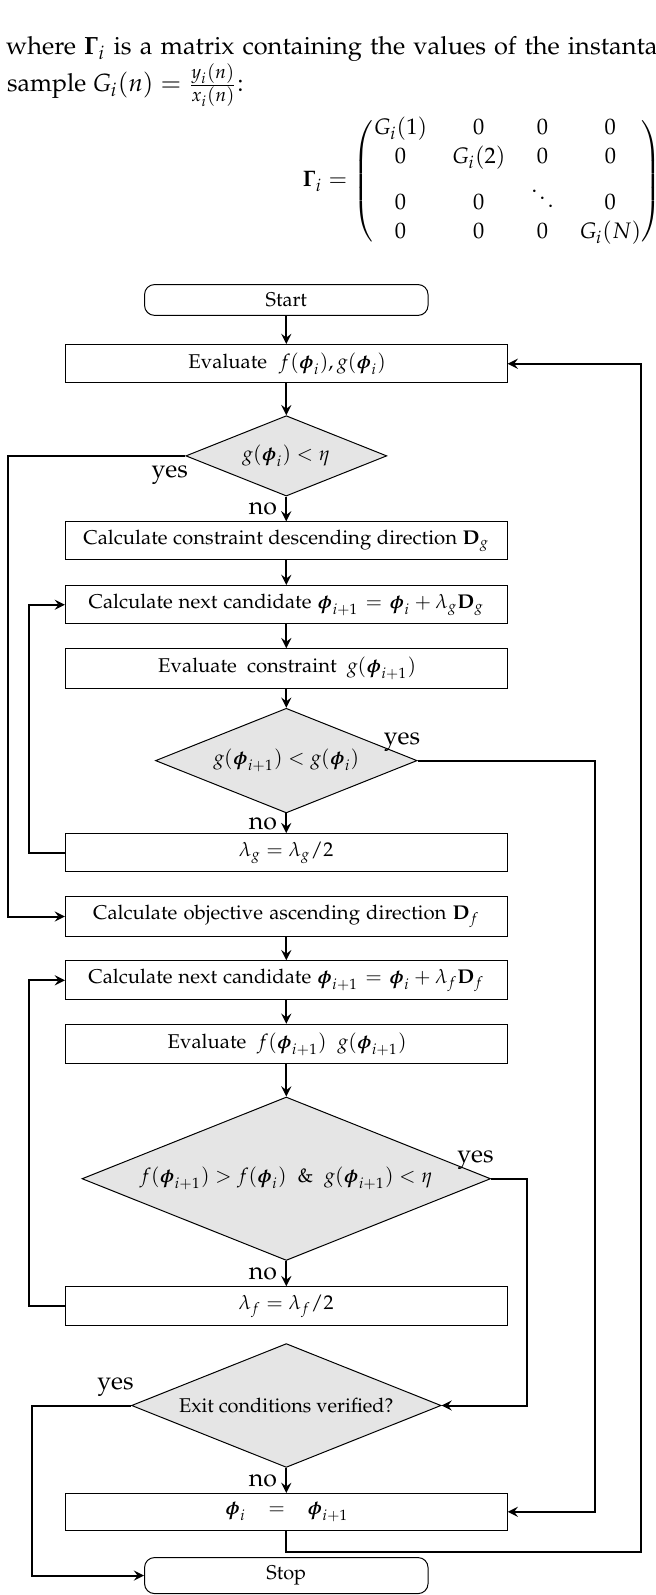
Figure 4. Flow chart of the constrained optimization algorithm exploited for DPD. The gain matrix in (9) represents a first-order approximation of the Jacobian matrix as required by the Newton’s method. However, other choices for Γ could also be adopted, e.g., a fixed value matrix or a finite-difference approximation of the Jacobian. While